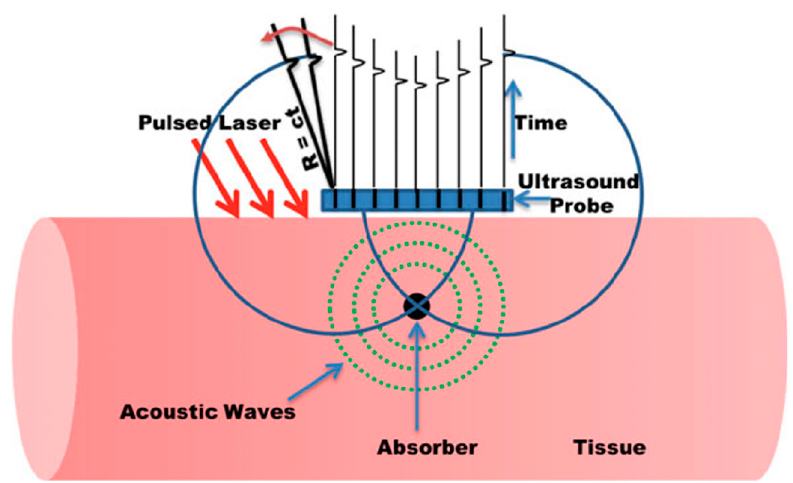
Figure 3. Back-projection PAI reconstruction for a planar detection geometry. Reproduced with permission from Handheld Probe-Based Dual Mode Ultrasound / Photoacoustics for Biomedical Imaging. In: Olivo M., Dinish U. (Eds) Frontiers in Biophotonics for Translational Medicine. Progress in Optical Science and Photonics, volume 3. Springer, Singapore (2016). Copyright 2016 Springer,